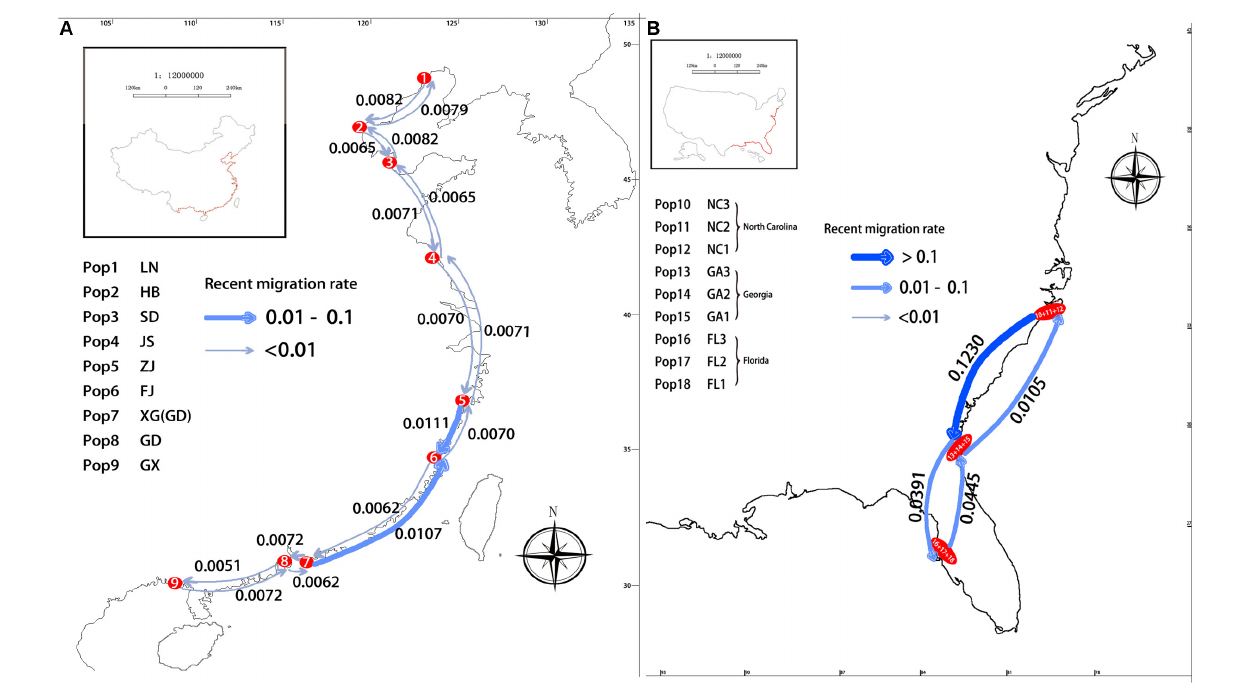
FIGURE 7 | Recent migration rate between pairs of neighboring populations (A) in China; (B) in United